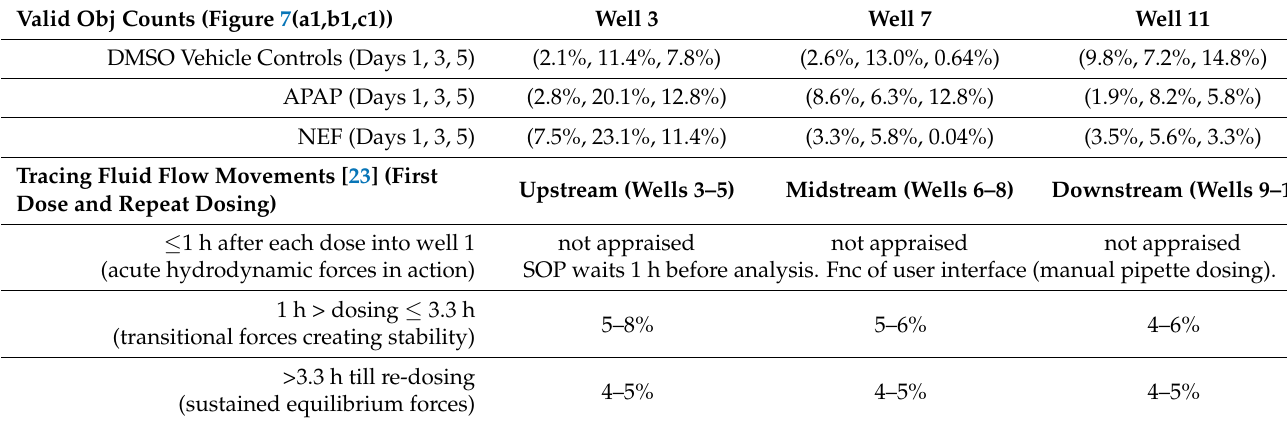
Table 2. Coefficient of Variation for Intra-Plate